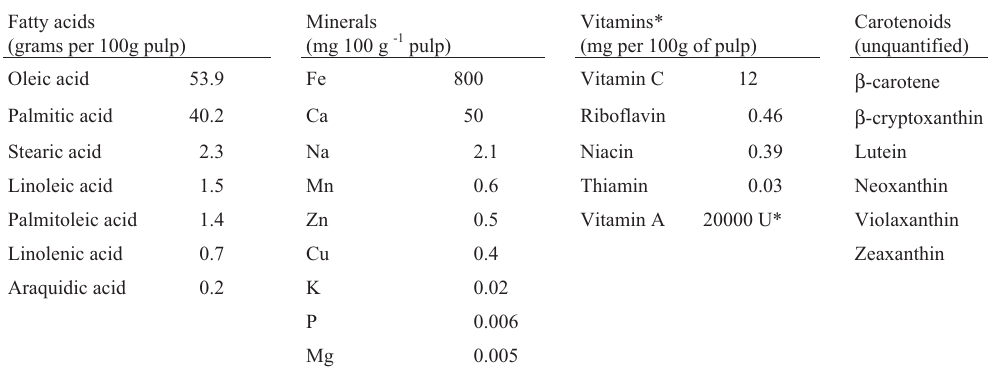
Table 3 - Main antioxidant compounds, minerals and vitamins present in Caryocar brasiliense (pequi) pulp. Fatty acids (grams per 100g